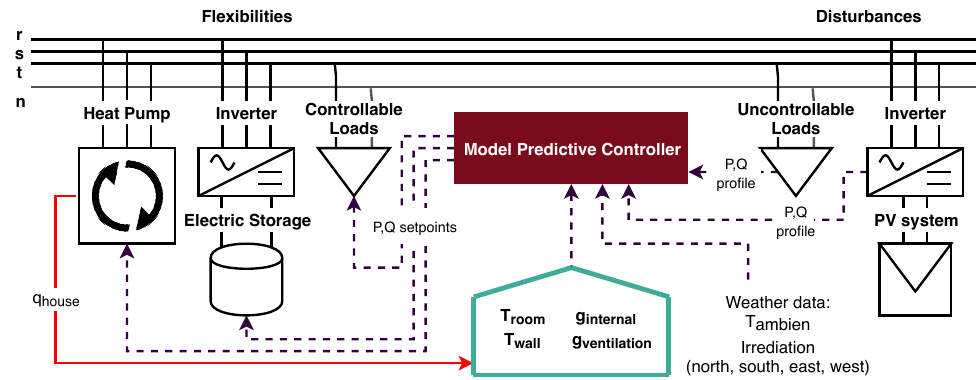
Figure 3. Schematic of three-phase HEMS with model predictive controller. It shows all the interconnections with respect to data exchange.